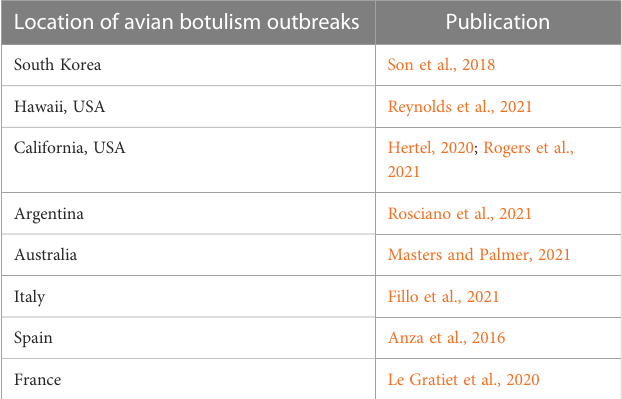
TABLE 1 Examples of publications reporting avian botulism outbreaks around the world, over the last